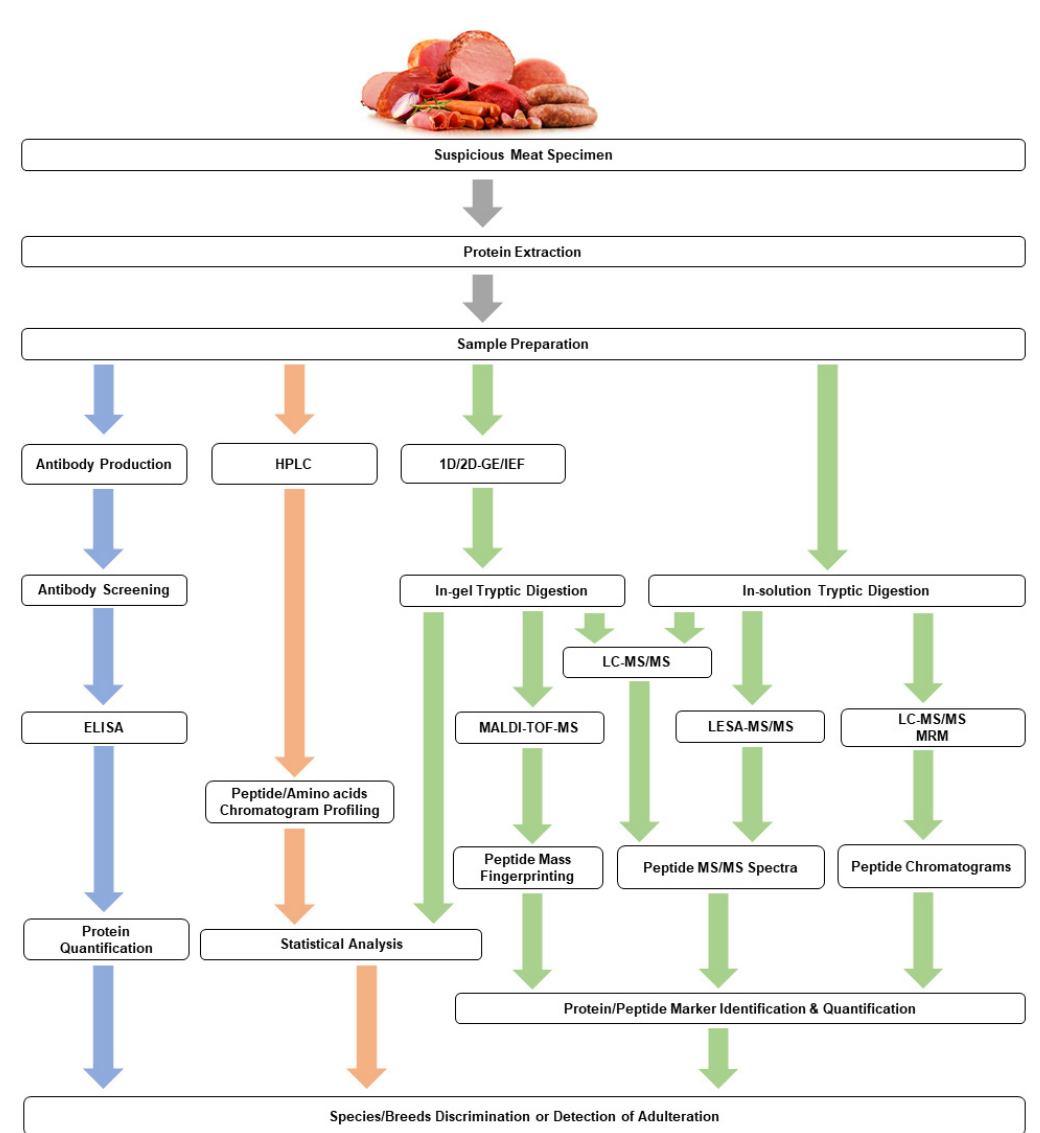
Figure 2. An overview for workflow performed previously in chicken proteome markers discovery. Blue arrows indicate the immunological approach, red arrows represent the chemical chromatogram profiling, and green arrows represent the bottom-up proteomics approach. The top-down proteomics approach is not shown due to no research reported using this approach in chicken authentication studies.